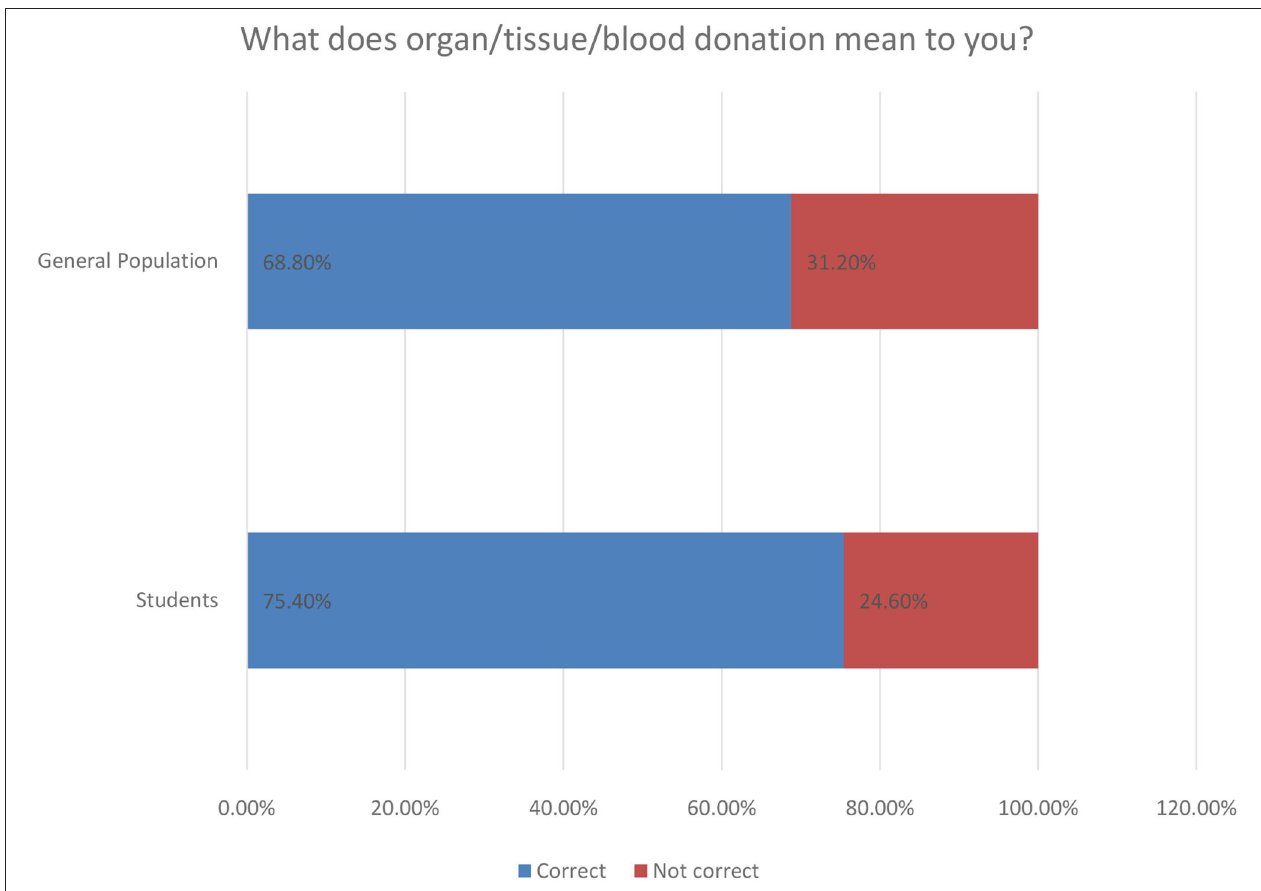
FIGURE 1 | Attitude toward organ/tissue/blood